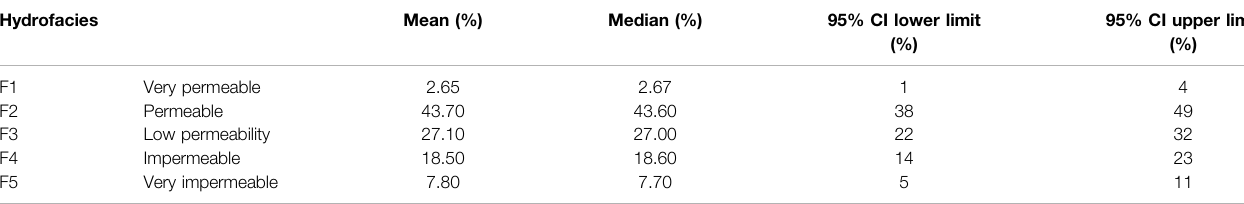
TABLE 1 | Statistics of the bootstrap distributions for the different hydrofacies.